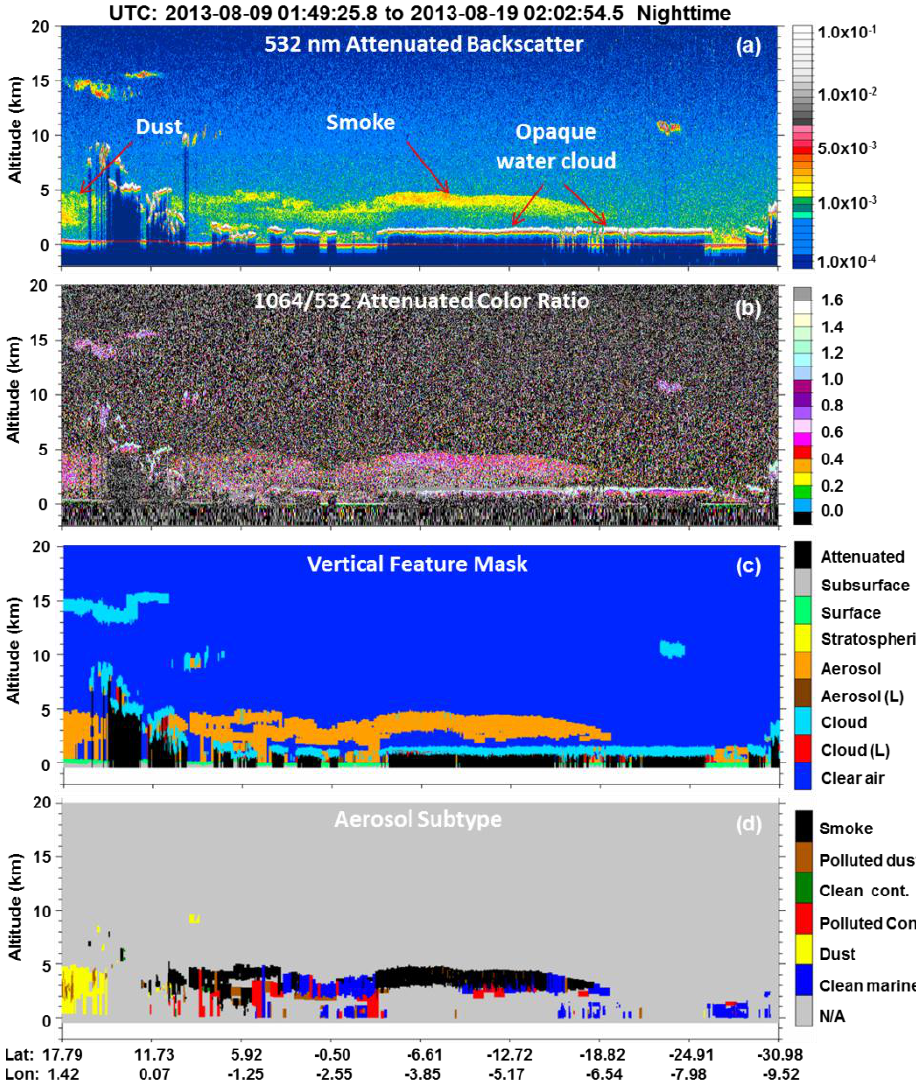
Figure 4. Example of CALIOP measurements of aerosols (smoke and dust) over water clouds made on 9 August 2013. (a) 532nm attenuated backscatter, (b) attenuated backscatter color ratio (1064/532), (c) vertical feature mask, and (d) aerosol